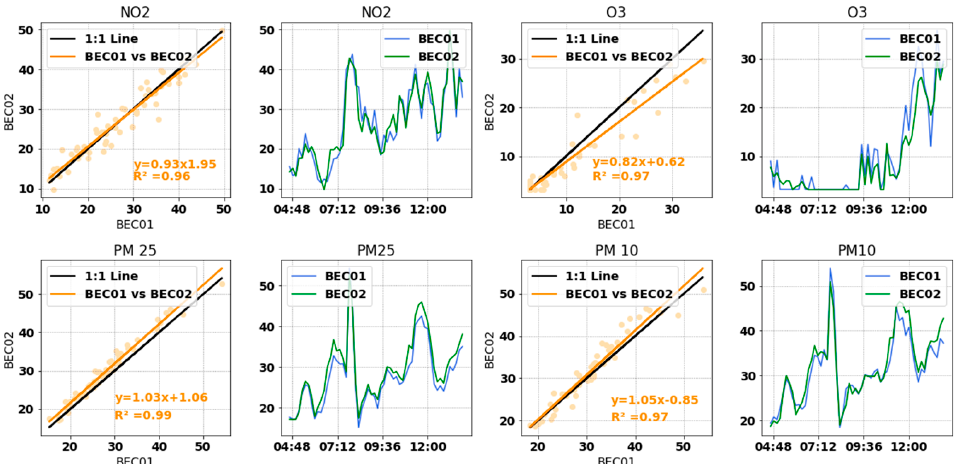
Figure 10. Scatter plots and temporal evolution of BEC01 and BEC02 after calibration. Orange indicates points and least-squares line of BEC01 vs. BEC02; blue represents BEC01 and green represents BEC02. Measurement unit is micrograms per cubic meter ( μ g/m 3 ).